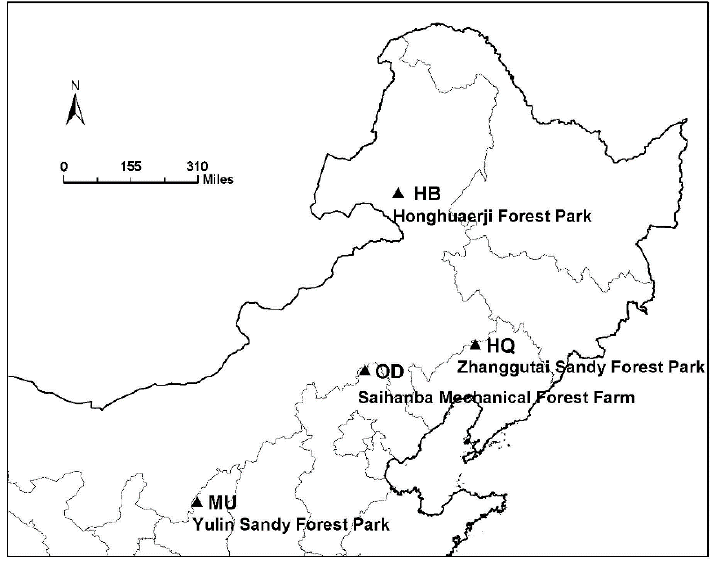
Figure 1. Sampling locations. HB: the Hulunbuir Sandy Land; OD: the Otindag Sandy Land; MU: the Mu Us Sandy Land; HQ: the Horqin Sandy Land.